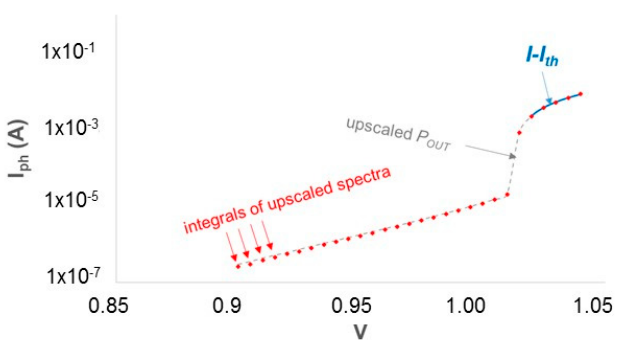
Figure 15. Three curves drawing the current I ph as a function of the external laser voltage V. The first is the difference I-I th measured from the DC characteristics. The second (upscaled P OUT ) is in practice the photocurrent created in a monitor diode by the laser radiation, suitably upscaled to coincide with the over-threshold I-I th . The third is made of the integrals of several spectra, multiplied by a suitable common constant that brings their value to overlap the upscaled P OUT curve.